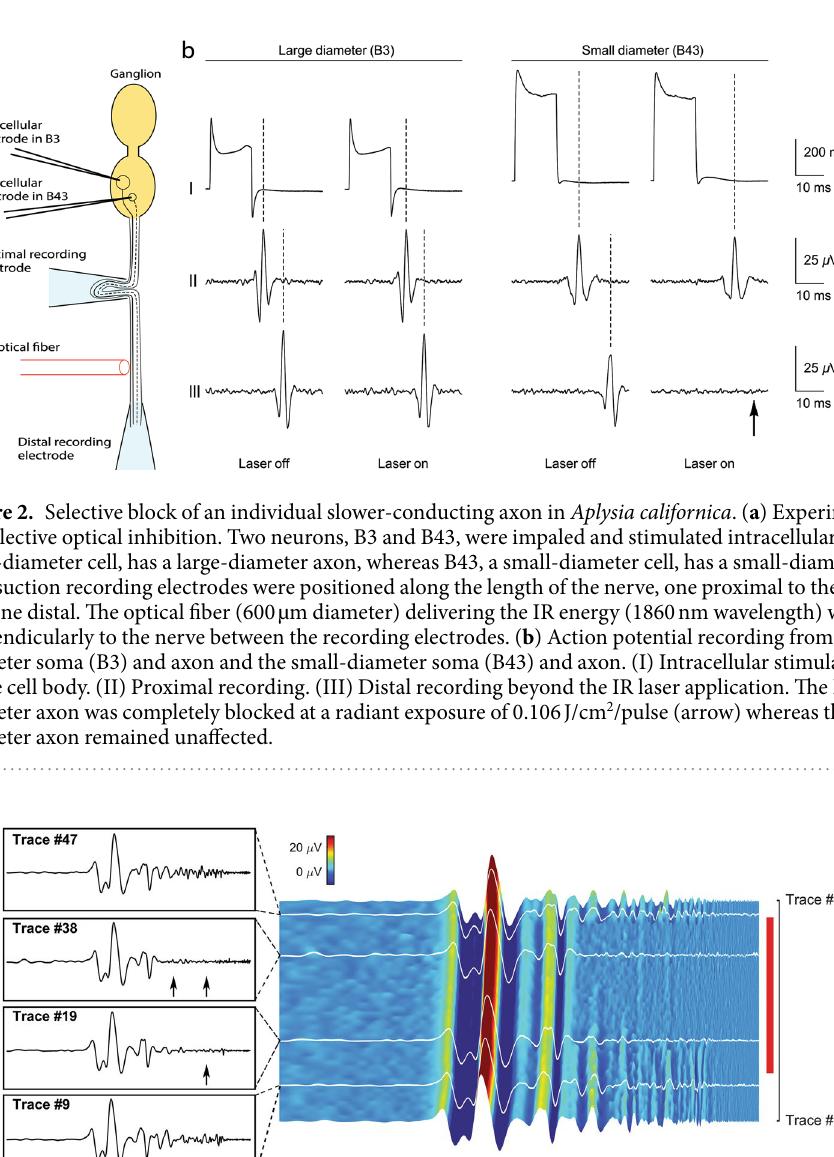
upper thoracic end and was recorded from the cervical bundle. The laser was also applied to the cervical vagus between stimulating and recording electrodes. Within 14 seconds after the laser was turned on at a radiant expo- sure of 0.064 J/cm 2 /pulse, the slowest and intermediate components (0.68–0.35 m/s) of the CAP were blocked [Fig. 4 trace 41 compared to trace 10]. Once the laser was turned off, all components of the CAP returned [Fig. 4, trace 59]. Over the 60 traces, the process of inhibition selectively affected the slowest components [Fig. 4, contour plot]. To quantify the changes, we again divided the CAP into regions of low variability, and the RAUC was meas- ured [Figure S10]. Each experiment was repeated 3 times/animal and in 3 different animals [data from a second preparation is shown in Figure S11]. Using Cochran-Mantel-Haenszel tests, slow-velocity components showed statistically significant reductions when compared to fast-velocity components in all preparations. The average